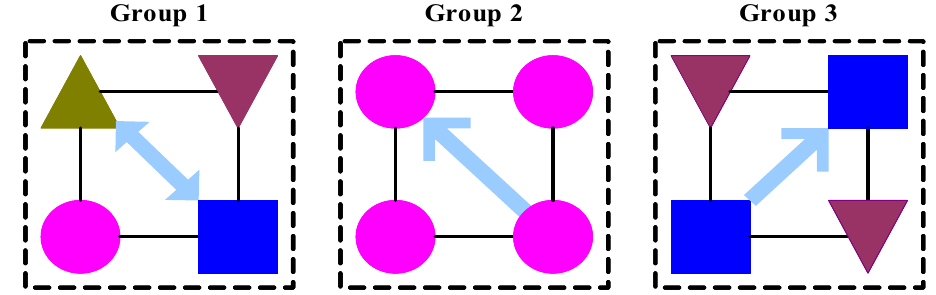
Figure 3: The relationship between color, shape, position, and visual volume of geometric forms.